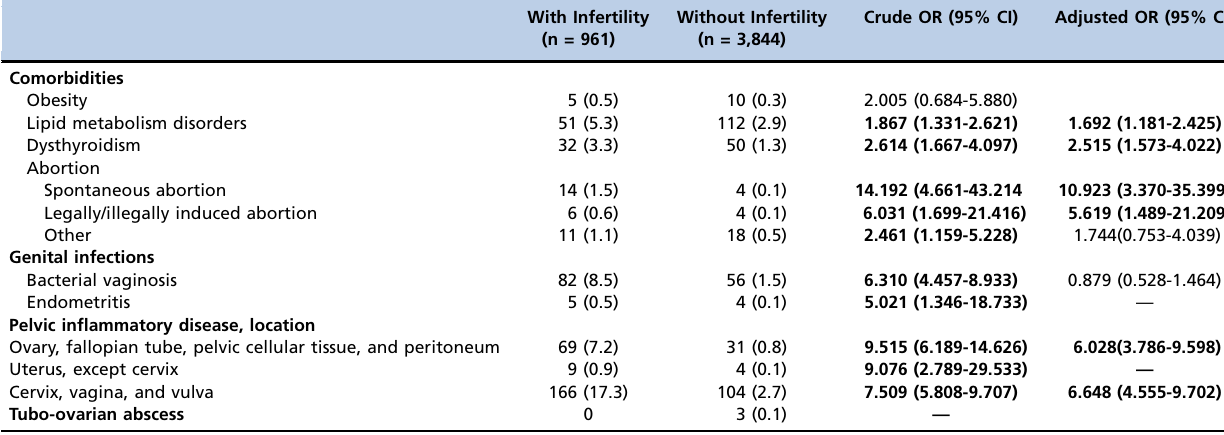
Table 3 - Risk factors for infertility in women aged 4 40